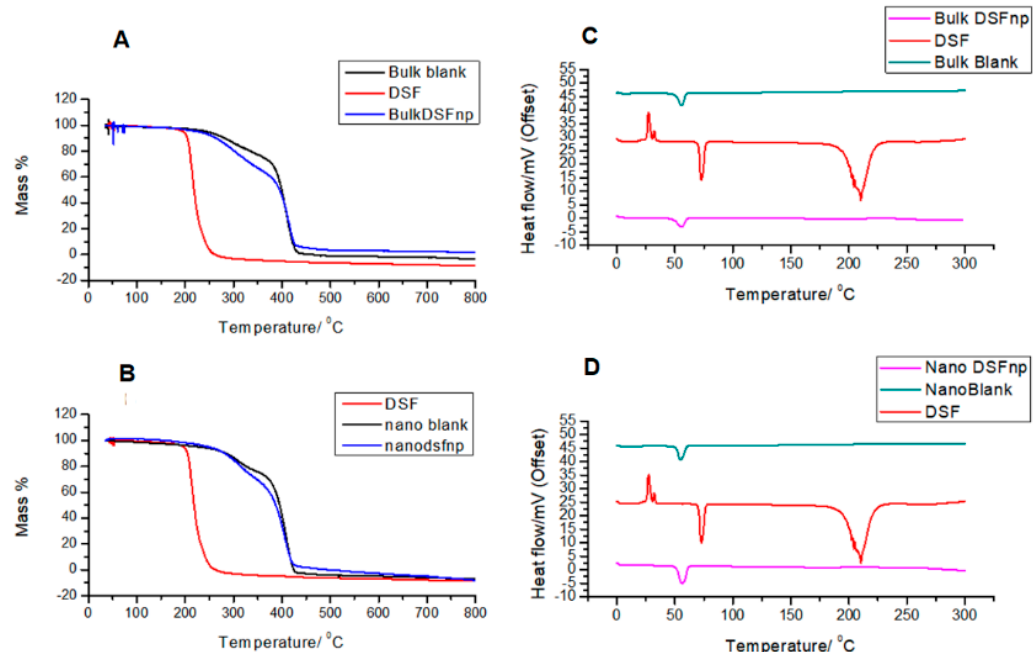
Figure 4. Graphs showing thermal degradation profiles of disulfiram, blank and loaded nanoparticles: ( A ) blank formulations. ( B ) microfluidic formulations. Relative DSC curves are shown with offset heat flow values for comparison: ( C ) emulsification solvent evaporation formulations. ( D ) microfluidic formulations.